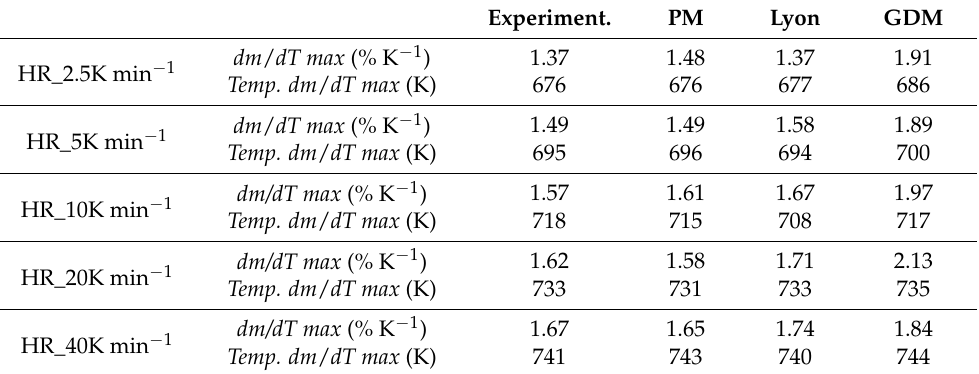
Table 4. Comparison of dm / dT maximum values and temperatures for PA 6.6.